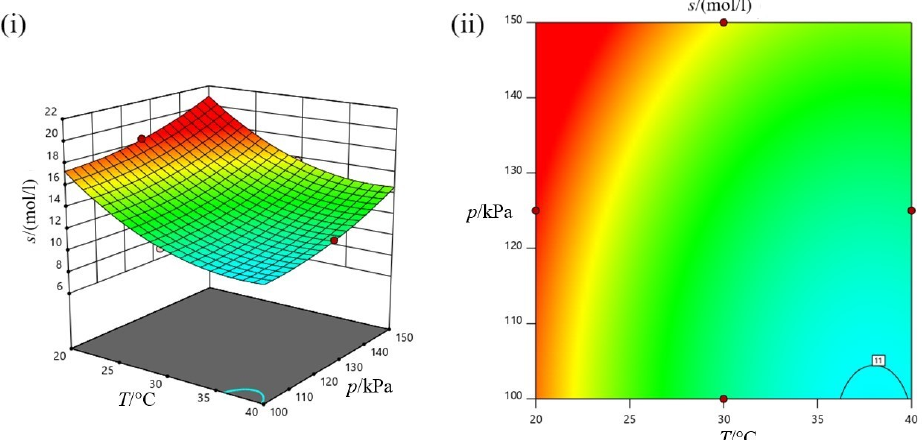
Figure 9. Effect of pressure, temperature and their interaction on CO 2 concentration in culture media with MEA ( i ) three-dimensional surface plot; ( ii ) projected contour plot.